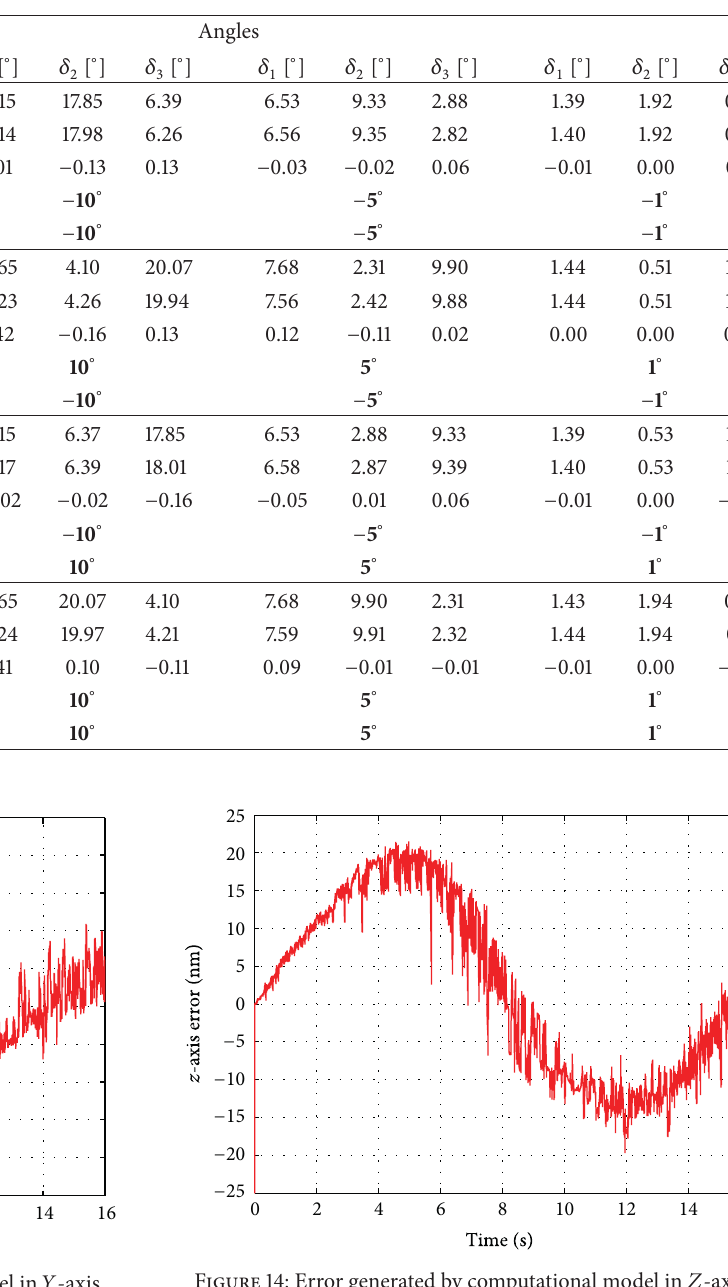
Table 1: Example results of the inverse kinematics for rotational movement of the piezoelectric actuators.